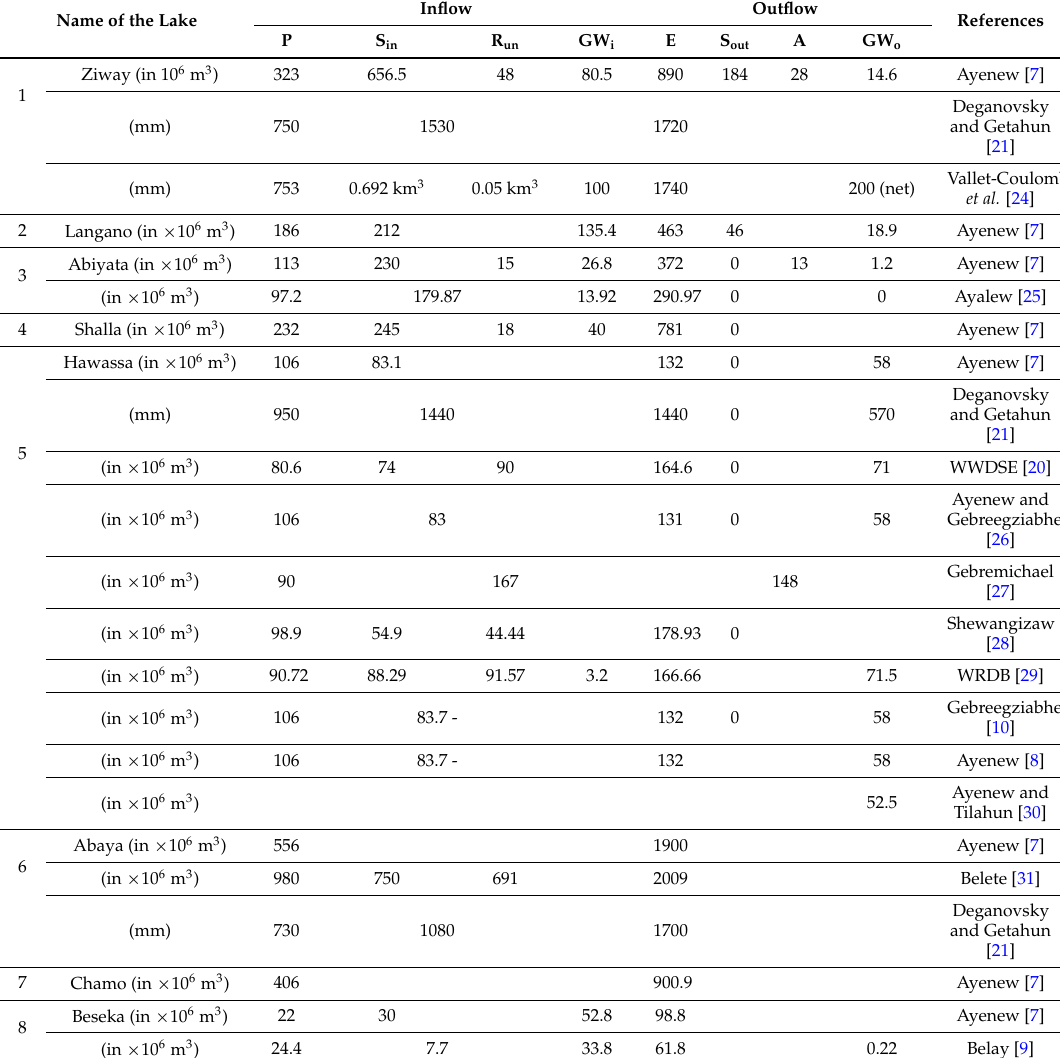
Table 2. Water balance components of the eight Rift Valley lakes (the units are as appeared in their respective literatures, no conversion